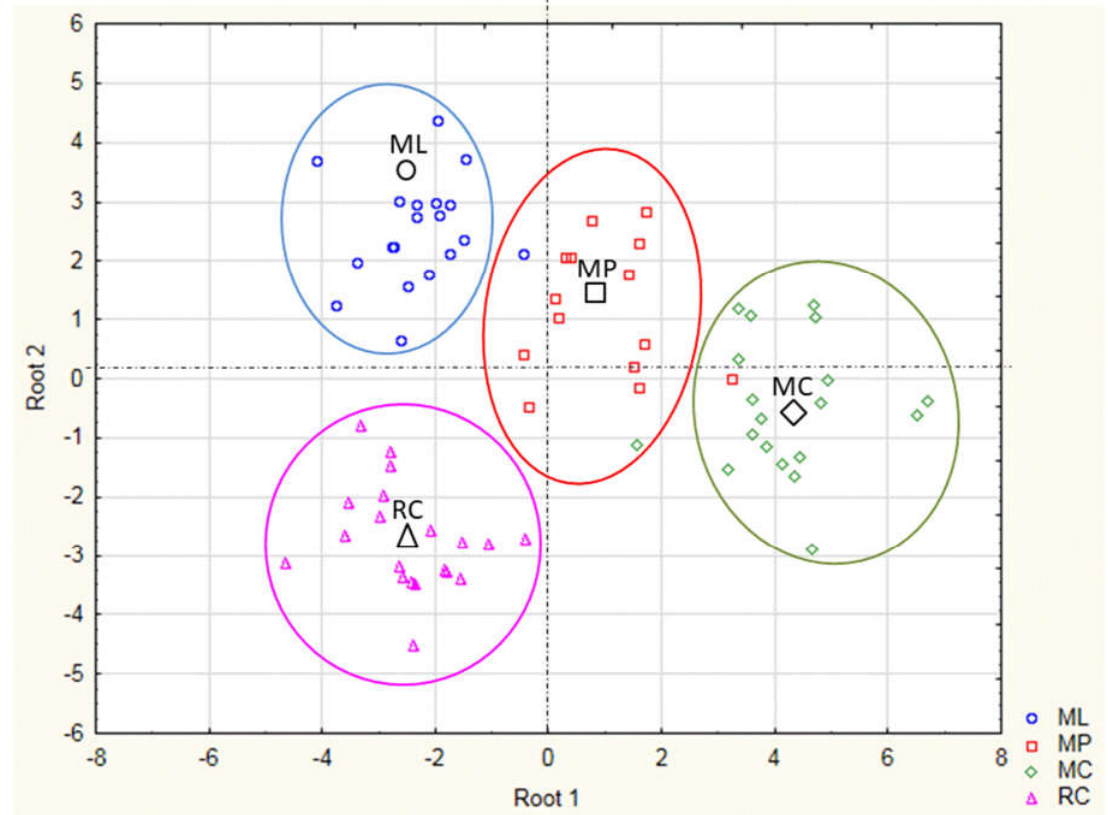
Figure 1. Plot of canonical discriminant analysis between ML (Mallorquina suckling lambs), MP (Mallorquina light lambs on pasture), MC (Mallorquina light lambs on concentrate) and RC (Red Mallorquina light lambs on concentrate) according to different production systems on the Balearic Islands. Table 6. Summary of stepwise regression for organoleptic and nutritional variables to discriminate Mallorquina and Red Mallorquina from a traditional production system on the Spanish Mediter- ranean Islands. F -Values p